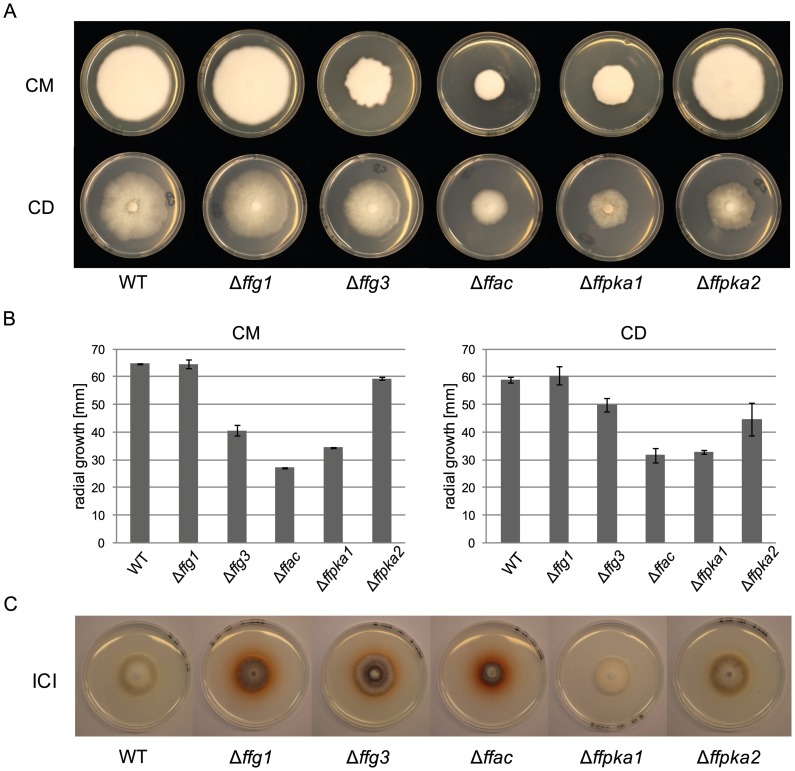
Analysis of growth behavior of the cAMP pathway mutants on different media compared to the WT.A) WT and cAMP pathway mutants (Δffg1, Δffg3, Δffac, Δffpka1, Δffpka2) were grown on solidified ICI medium with 6 mM sodium nitrate as sole nitrogen source. B) WT and cAMP pathway mutants on solidified complete medium (CM) and Czapek dox (CD, minimal medium). After 7 days radial growth rates of the respective mutants was determined. Experiments were done in triplicate. C) Radial growth of the respective mutants grown on CM or CD medium was measured [mm]. Mean values and standard deviations are shown in the diagram.